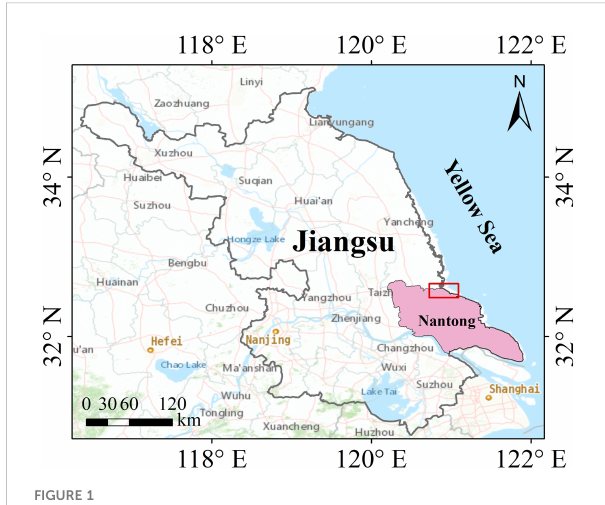
FIGURE 1 Map of the location of the study